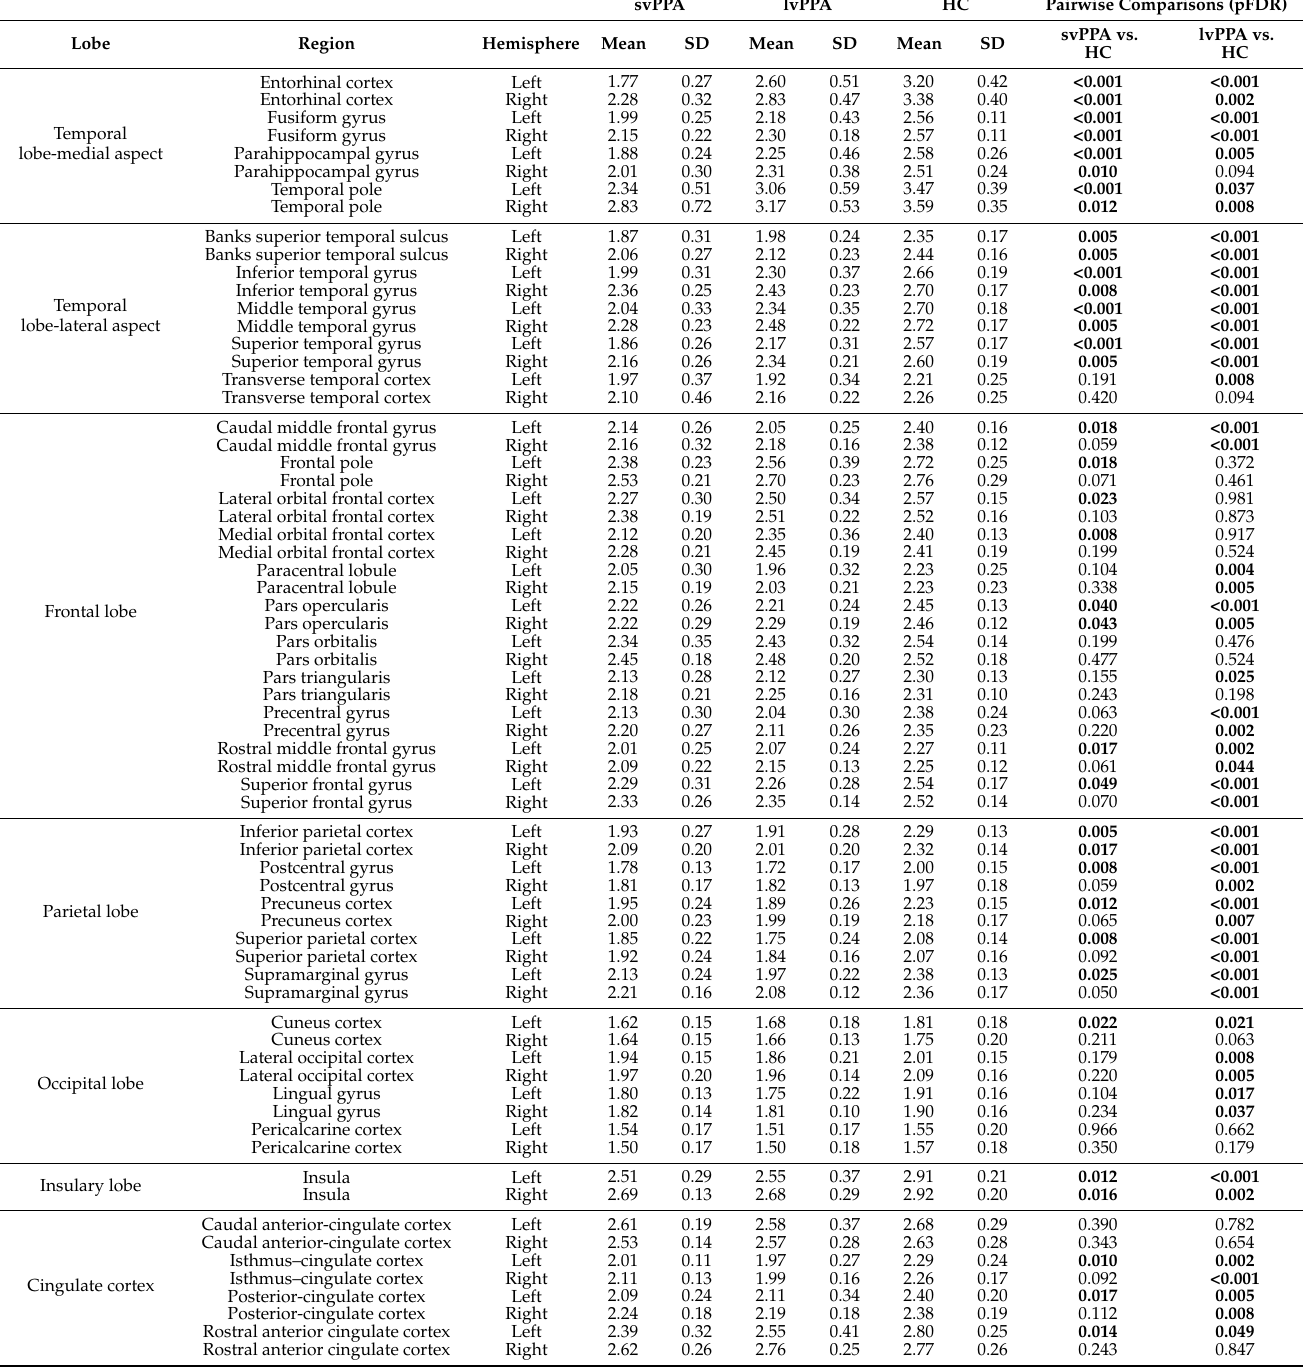
Table 3. Means and standard deviations of the cortical thickness of brain regions extracted using the Desikan’s atlas in the three groups (svPPA, lvPPA, and HC) and comparisons performed between each clinical group and healthy controls (HC) with Mann–Whitney U Tests. Abbreviations: SD—standard deviation; svPPA—semantic variant of Primary Progressive Aphasia; lvPPA—logopenic variant of Primary Progressive Aphasia. P-values were adjusted using the False Discovery Rate—(FDR) correction (Benjamini and Hochberg, 1995). In bold are reported statistically significant